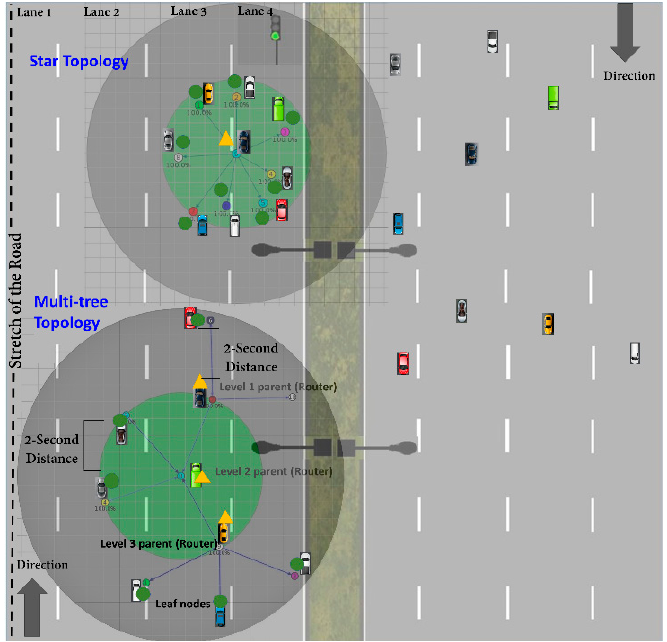
Figure 1. Highway traffic scenario for vehicular grouping.